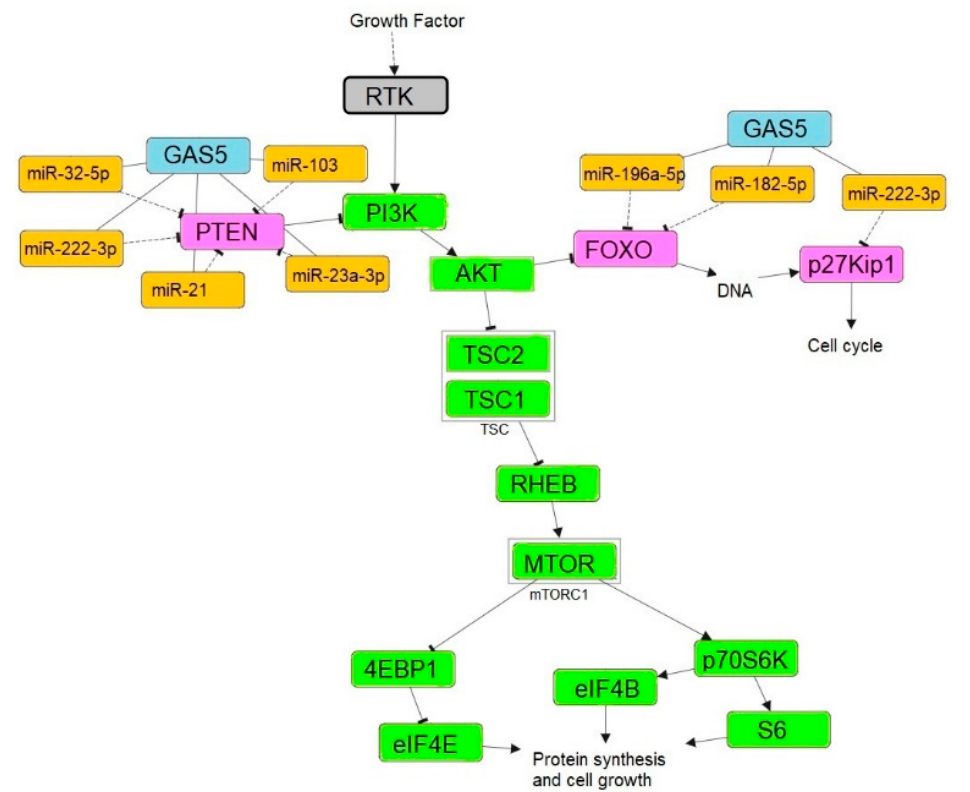
Figure 6. Schematic representation of PI3K/AKT/mTOR pathway. GAS5 inhibits the repression of tumor suppressor gene expression such as PTEN , FOXO and p27KIP1 via sponging oncomirs. Pathway was constructed using PathwayMapper [83]. Receptor tyrosine kinase (RTK), Ras homolog enriched in brain (RHEB), Tuberous sclerosis complex 1 and 2 (TSC1 and TSC2).